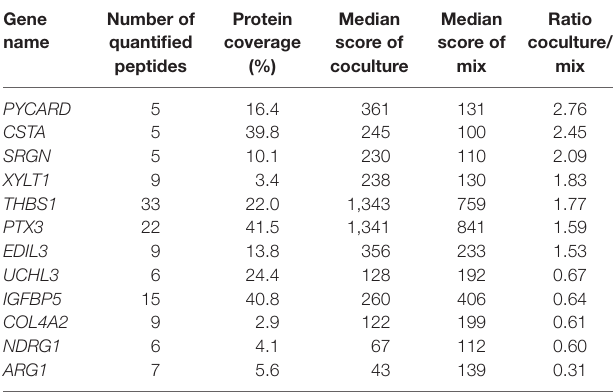
Table 2 | Proteins identified in the secretome of chondrocyte/adipose stem cells (ASC)